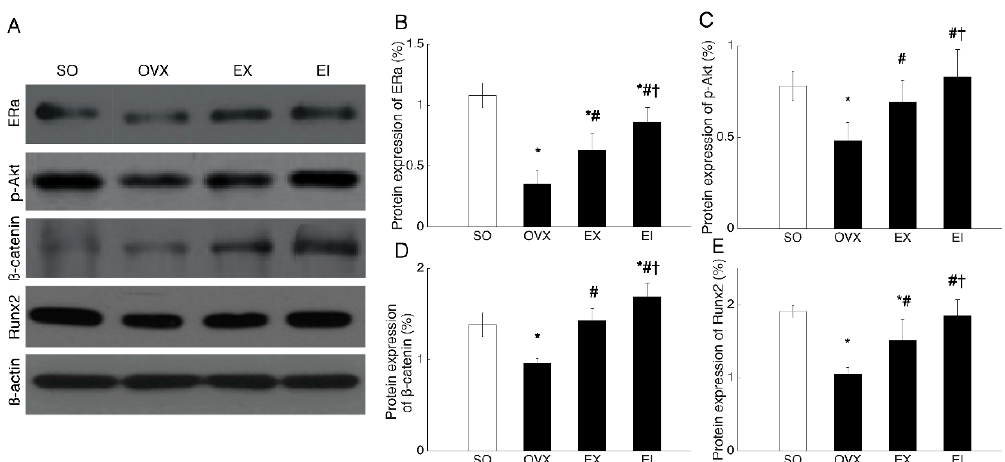
Figure 2. The protein expression of ER α , p-Akt, β -catenin, and Runx2 in osteoblast culture. SO: Sham- operated; OVX: ovariectomized; EX: exercise; EI: exercise and Icariin. 1. Comparison of the groups of OVX, EX, and EI with SO group: * <0.05. 2. Comparison of EX and EI groups with OVX group: # <0.05. 3. Comparison between EX with EI group: † <0.05.